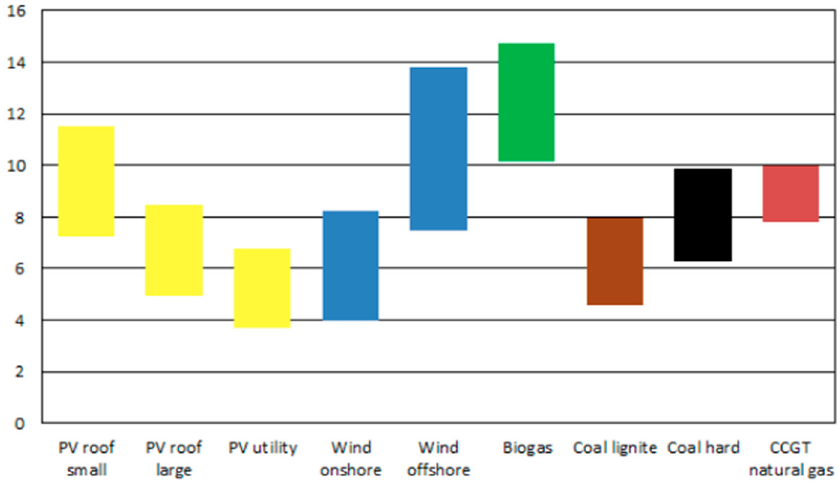
Figure 1. Levelized cost of electricity generation in Germany in eurocent per kWh in 2018 (source: Fraunhoffer-ISE [22]).